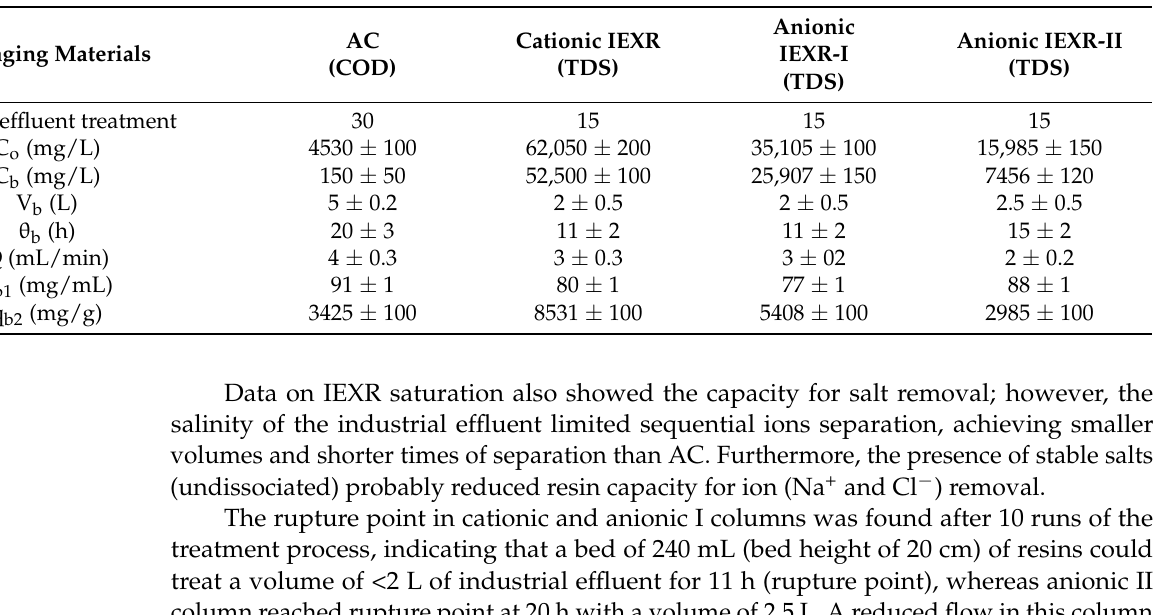
Table 3. Data of removal contaminants capacity of packaging materials (AC and IEXR) during industrial effluent treatment in columns with 20 cm of bed height.